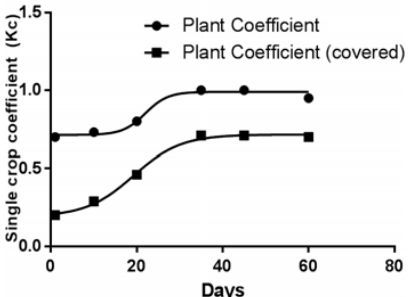
Figure 1. Lettuce crop coefficient for non-covered and surface covered cultivation assuming planting of seedlings after 15 days (in the graph shown as day 0).